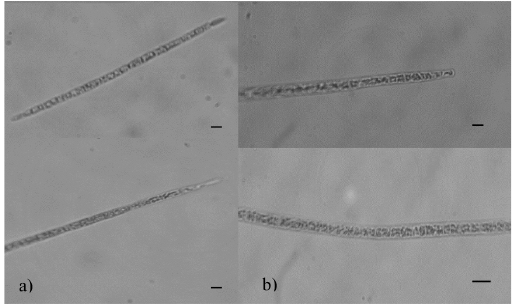
Figure 4. Isolated species: a) Cylindrospermopsis racibor- skii (IRA02); b) Planktothrix agardhii (IRA07). Scale bar: 10 μm.